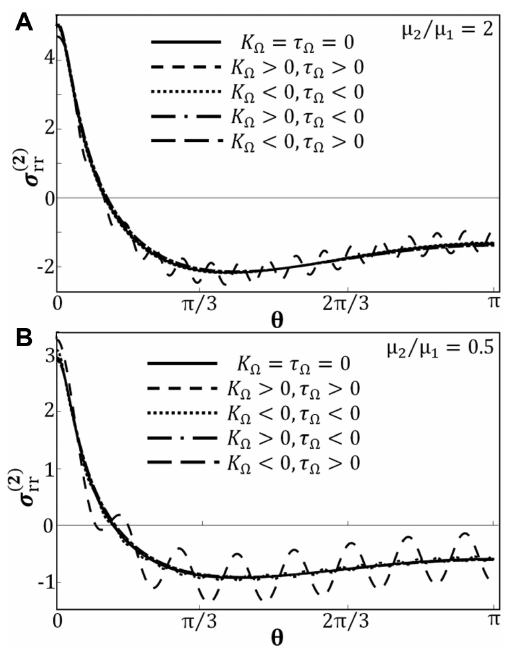
along the rr = ν = 0.3, μ = 2 (A) and / μ 1 2 2 1 and τ . Stress values are given in Ω Ω